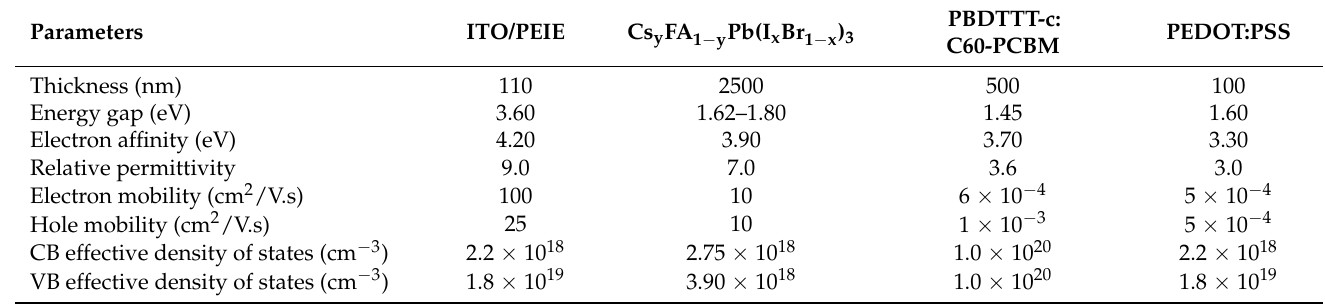
Table 1. Basic parameters of the narrowband PD layers [28,29,34–39].